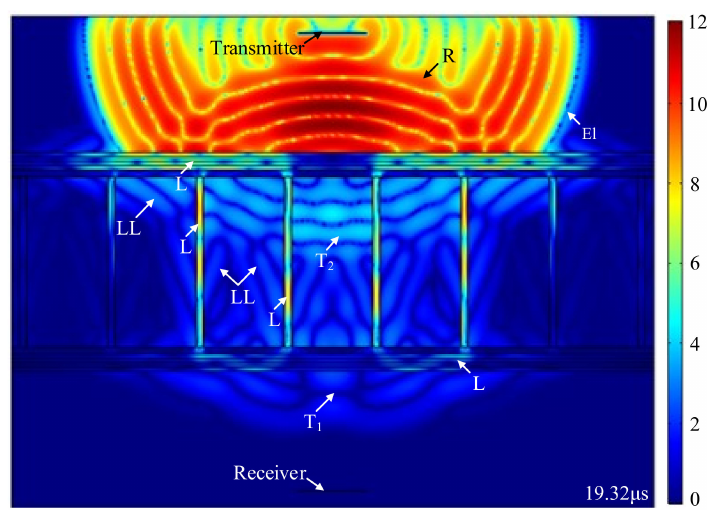
Figure 7. The simulation result of sound field distribution with 19.32 µ s in honeycomb sandwich